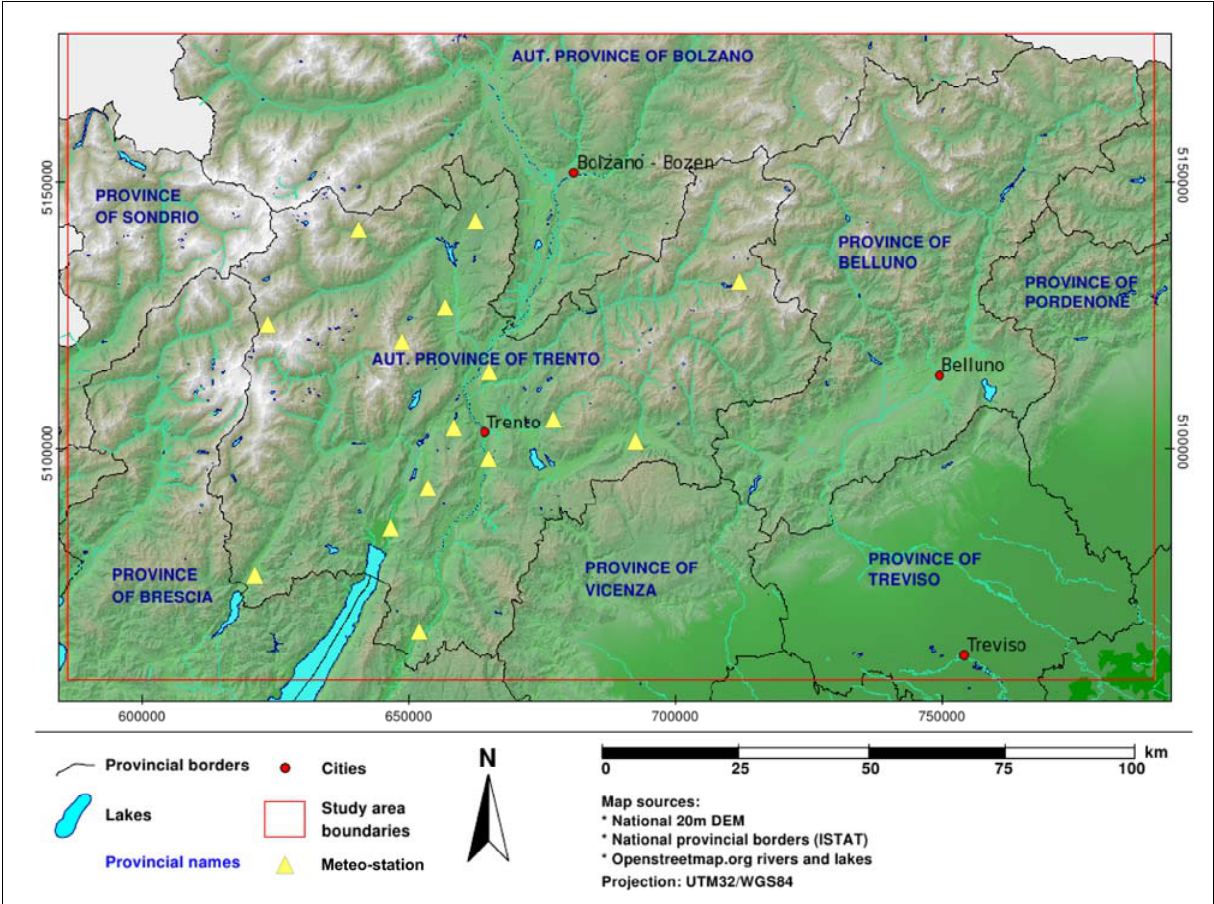
Figure 1. Study region in Northern